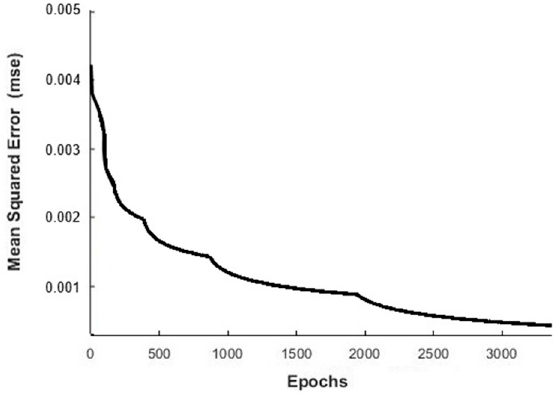
Figure 3. Mean square error evolution with the number of epochs.